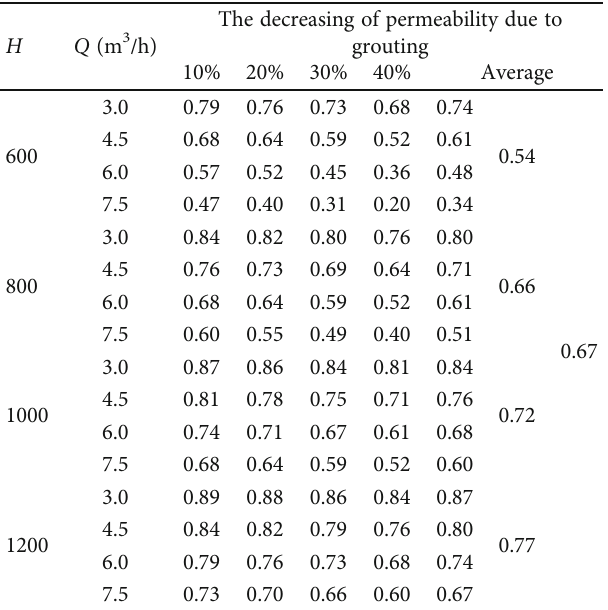
Table 2: The water pressure reduction coe ffi cient under typical parameters.